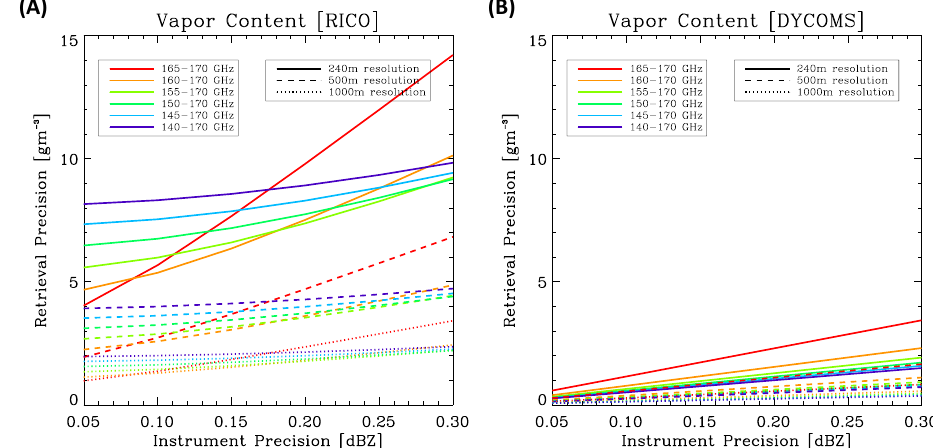
Figure 9. Estimated CWV retrieval precision as a function of instrument measurement precision for RICO (a) and DYCOMS-II RF01 (b) .